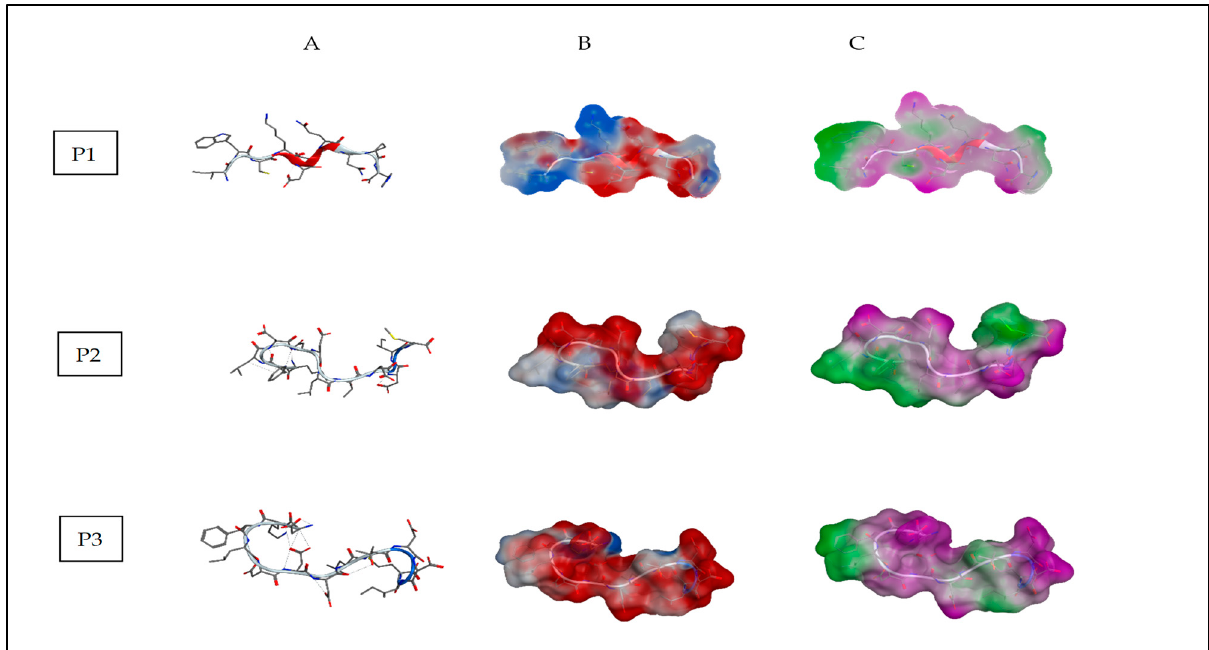
Figure 1. Three-dimensional representation of P1 (IWCKDDQNPH), P2 (DKFLDDDLTDDIM), and P3 (DKFLDDDLTDDIM) rendered by MOE showing conformations at 50 ns of the simulation. The P1 region that adopts an alpha helix structure contains KDDQ residues ( A ) and two molecular surfaces showing electrostatics. Blue indicates positively charged areas; red indicates negatively charged areas ( B ) and lipophilicity. Green indicates lipophilic areas; pink indicates hydrophilic areas ( C ).